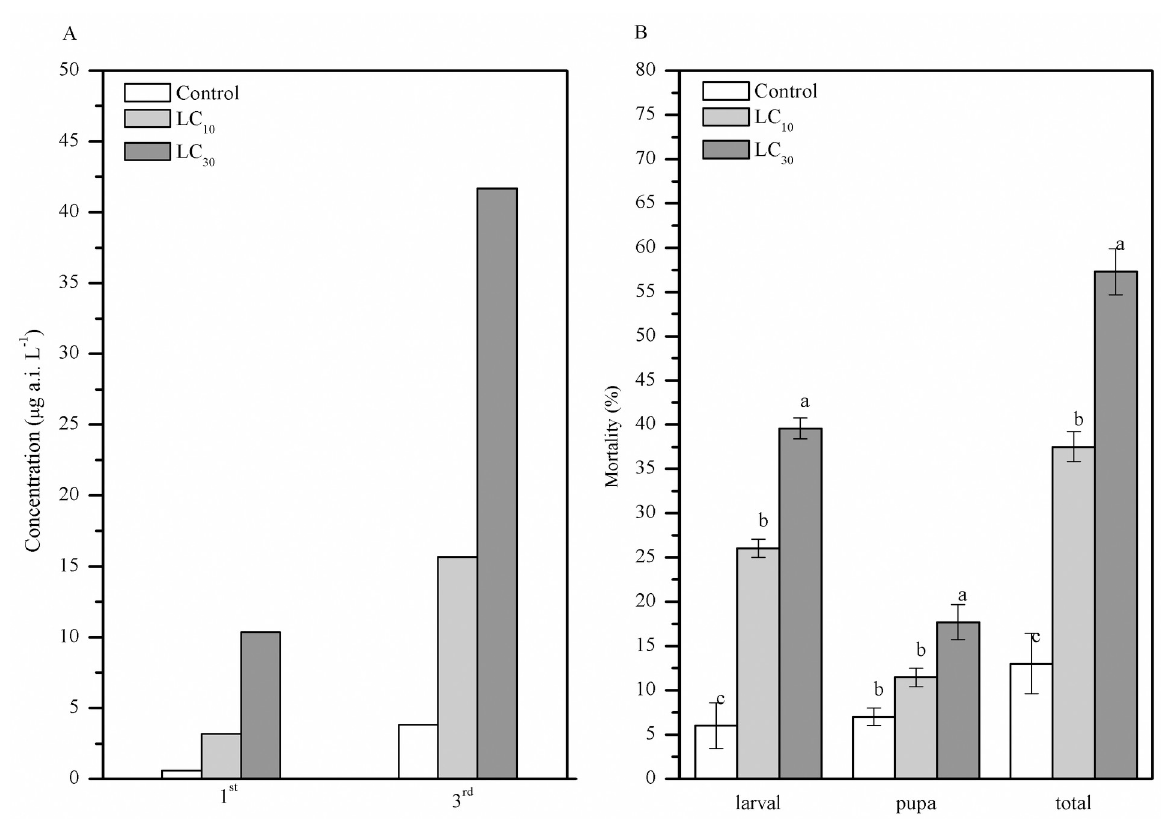
Fig 1. Toxicity of TCAP to S . exigua . A, LC 10 , LC 30 , and LC 50 of the 1 st and 3 rd instar larvae of S . exigua ; and B, The larval and pupal mortalities of S . exigua treated with TCAP. The bars labeled with different letters are significantly different (via Fisher’s protected least significant difference (LSD), P < 0.05).